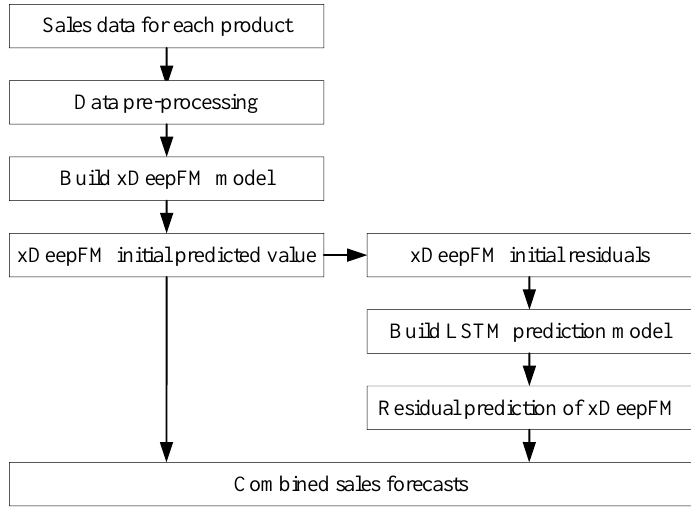
Figure 3. Flow chart of combined model